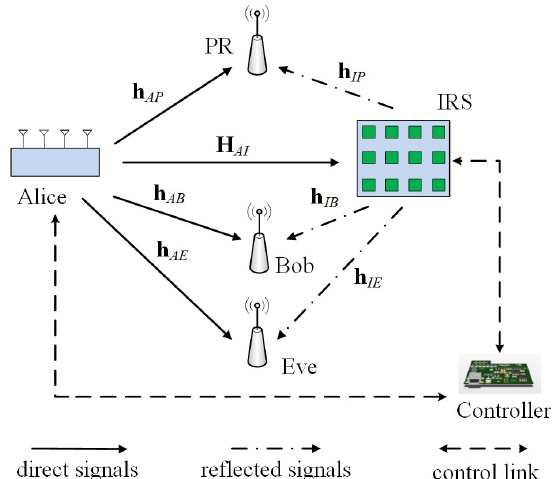
Figure 1. A block diagram of intelligent reflecting surface (IRS)-assisted Gaussian cognitive radio (CR) multi-input single-output (MISO) wiretap